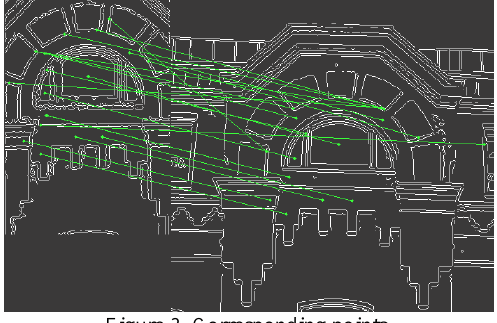
Figure 3. Corresponding